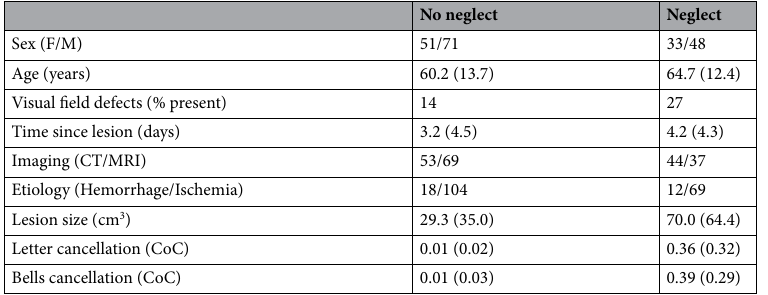
Table 1. Demographic and clinical data of the 203 patients included. For this table we determined whether a CoC (= Center of Cancellation; see Rorden and Karnath 28 ) score was in the pathological range; cut-offs were set at > .083 for the Letter Cancellation test and > .081 for the Bells Cancellation Task (cf. Rorden and Karnath 28 . A positive diagnosis of spatial neglect was assigned if a pathological test score in at least one of the two cancellation tests was detectable. 122 (60%) did not exhibit neglect, while 81 (40%) were classified as exhibiting spatial neglect. Data are represented as mean (SD). Note that in the statistical tests we treated the severity as a continuous measure. The table reveals that using cut-off thresholds, there is little variability in patients without pathological bias (ceiling performance). In contrast symptom severity varies across patients with pathological deficits. Modified from Wiesen et al. 10